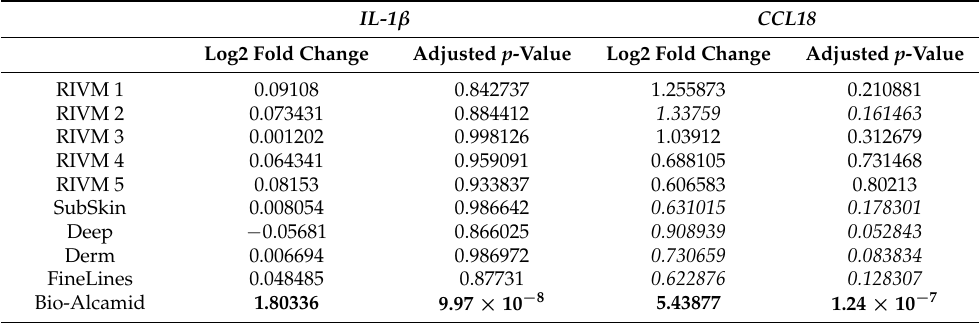
Table 3. Gene expression changes of IL-1 β and CCL18 from M0 macrophages derived from THP-1 cells exposed to RIVM preparations, Bio-Alcamid ® and Perfectha ® filler extracts. Significant gene expression with adjusted p -value < 0.05 and adjusted p -value < 0.2 are indicated in bold and in italics, respectively. IL-1 β CCL18 Log2 Fold Change Adjusted p -Value Log2 Fold Change Adjusted p